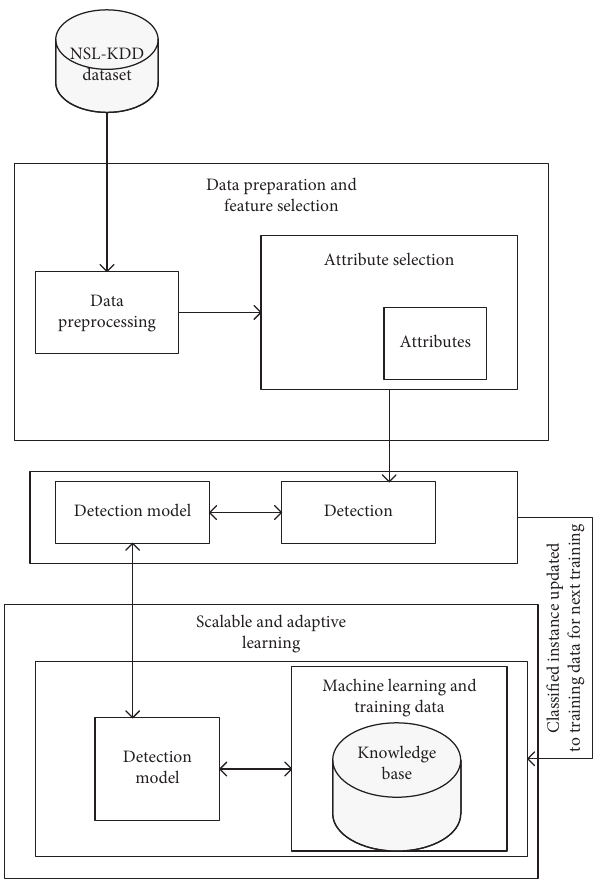
Figure 1: Scalable and adaptive learning approach for